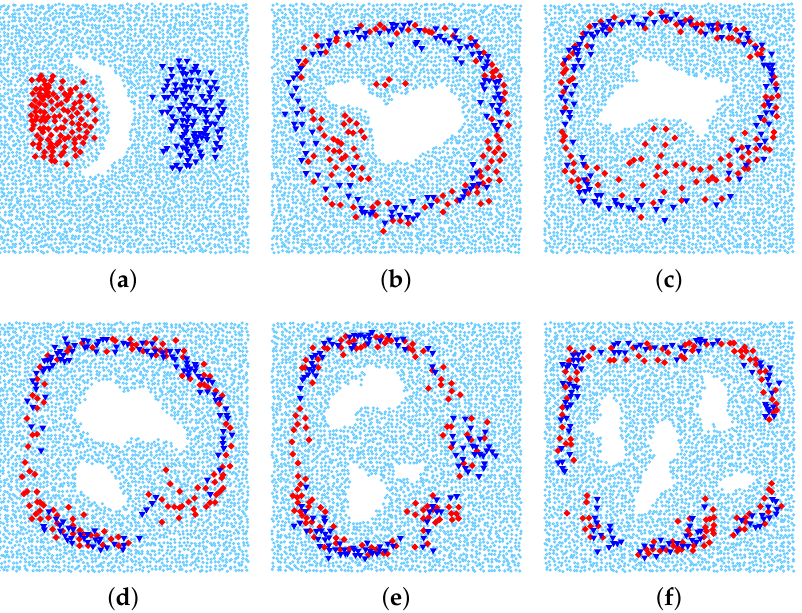
Figure 9. Network topologies for n-n communication [38]. The blue circles represent the sensors. The red diamonds represent the sources and the blue triangle represents the destination. ( a ) Topology